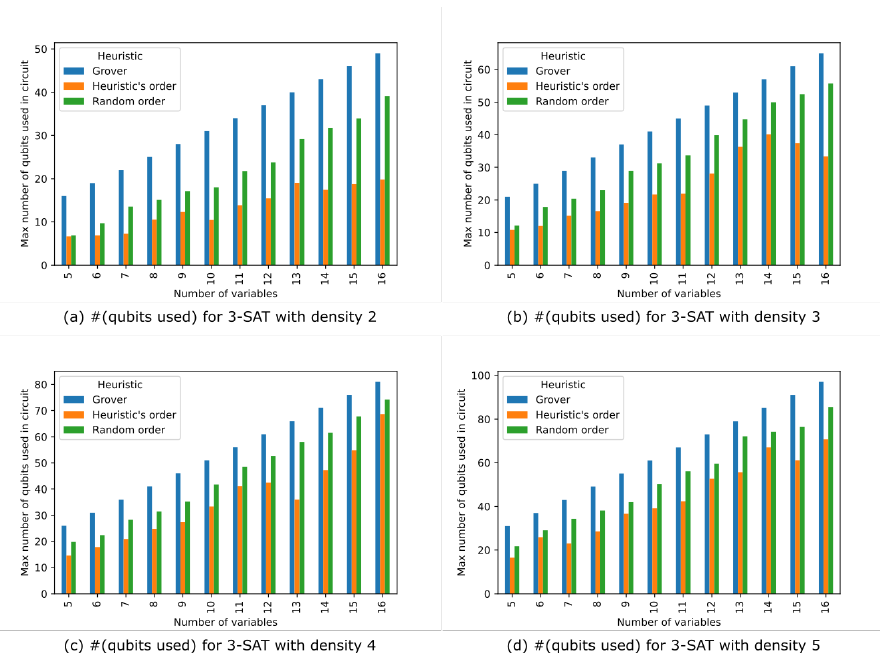
Figure 6. Comparisons of total number of qubits used stratified by the densities of 3-SAT formulas.